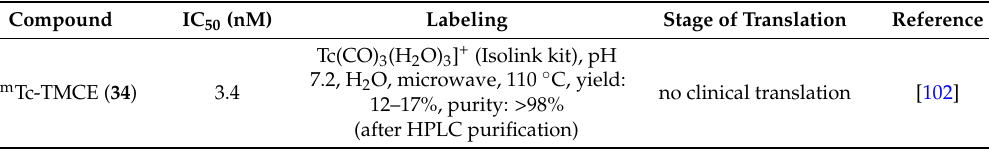
Table 4. Affinity, labeling and lipophilicity data of 99m Tc-TMCE.